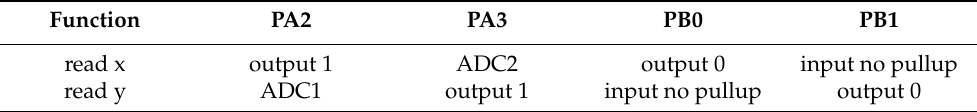
Table 1. STM32 F401C Disco pins configuration for communication with the touch panel.